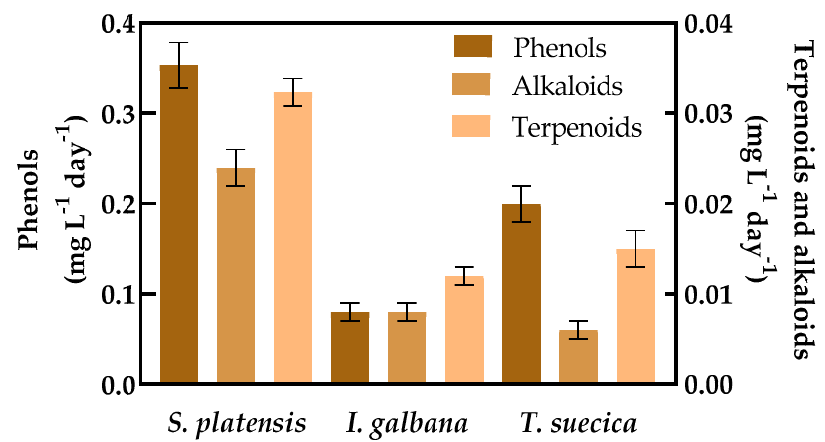
Figure 3. Antioxidant productivities in batch cultures. Phenols, alkaloids, and terpenoids productivities in S. platensis , I. galbana , and T. suecica in batch cultures under a supplied light intensity of 39.63 kJ d − 1 for 9 days of cultivation. Values are the means of 3 replicates ( p < 0.05). Table 4. Antioxidant concentrations in batch culture: tocopherols, carotenoids, phycocyanin (PC), allophycocyanin (APC), and superoxide dismutase (SOD) content in S. platensis , I. galbana , T. suecica , and P. cruentum in batch cultures supplied with a light energy of 39.63 kJ d − 1 for 9 days of culture.